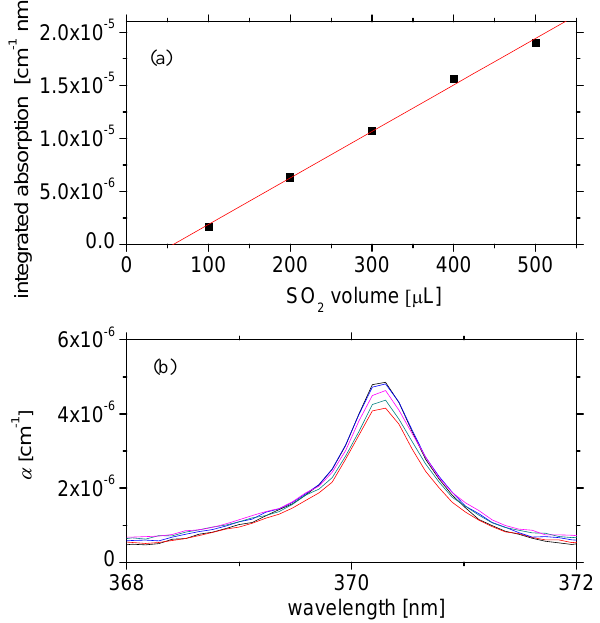
FIGURE 3. Fig. 3. (a) Dependence of the SO 2 integrated absorption on the volume of SO 2 introduced into the inlet stream. The correlation coefficient of the linear regression is R 2 = 0 . 9961. (b) Repeatability of five successive injections of 500µL SO 2 into the inlet stream. The standard deviation is 5% at the absorption peak at 370.2nm.